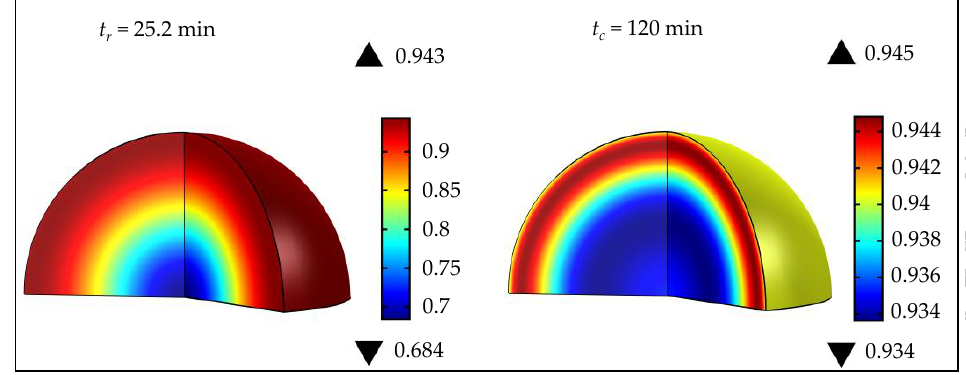
Figure 8. Vulcanization simulation of a sphere ( D = 5 cm) at the optimal temperature (150 °C), at t r and t c